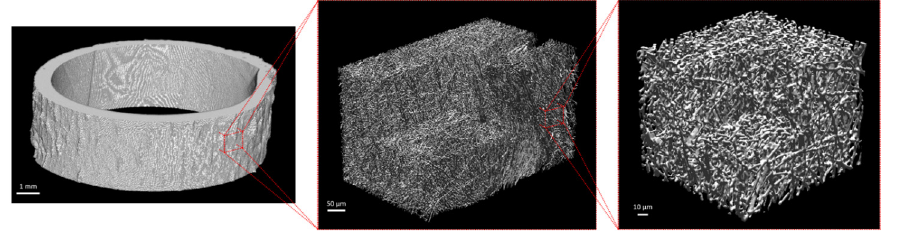
Figure 2. Three µCT 3D renderings at three magnifications: left : the whole matrix, middle : a large volume of interest (500 × 300 × 300 µm 3 ), and right : a small volume of interest (100 × 100 × 100 µm 3